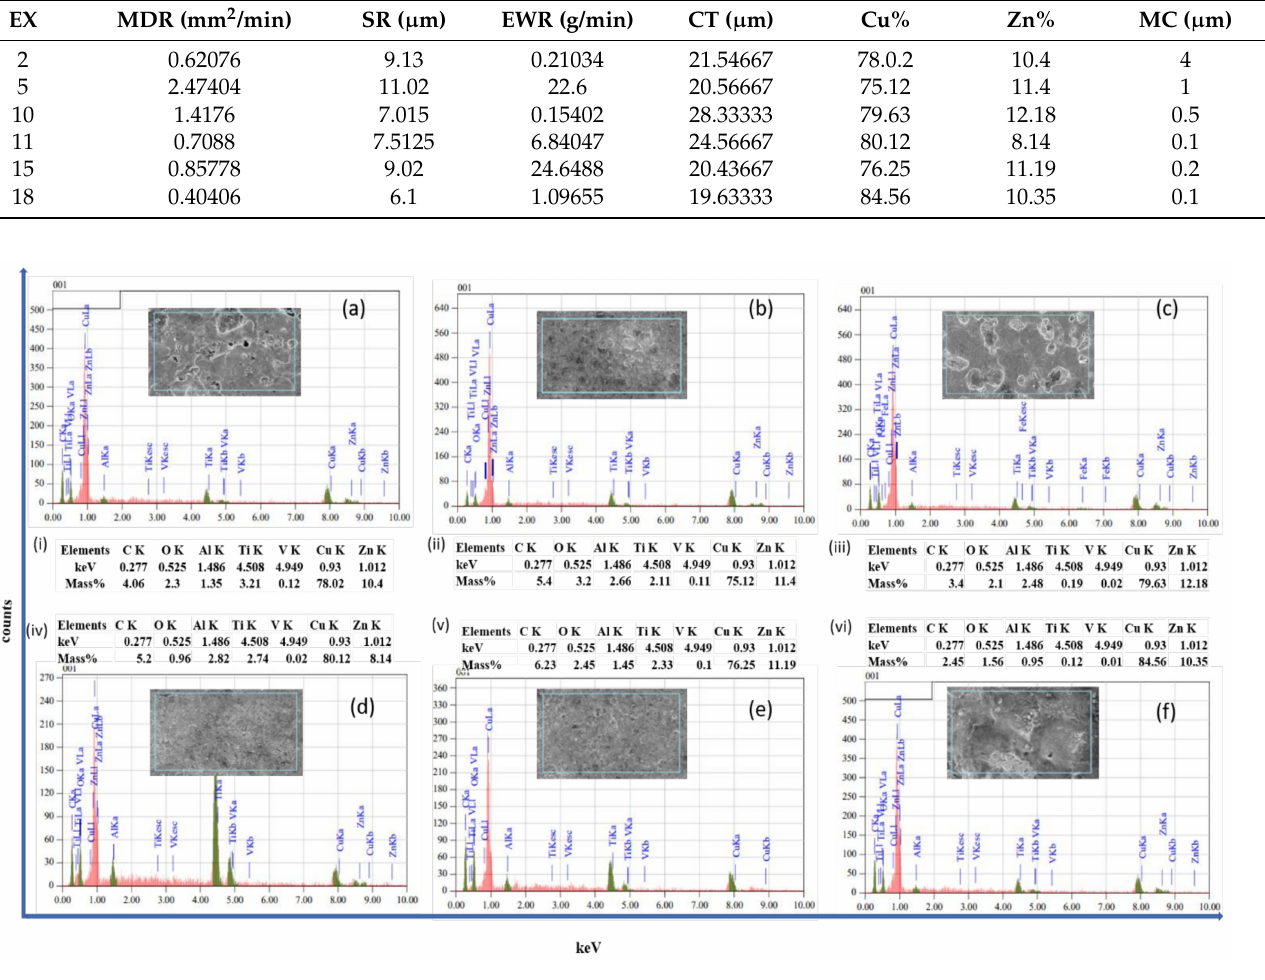
Figure 2. EDX Elemental Analysis: ( a ) EX 2, ( b ) EX 5, ( c ) EX 10, ( d ) EX 11, ( e ) EX 15 and ( f )